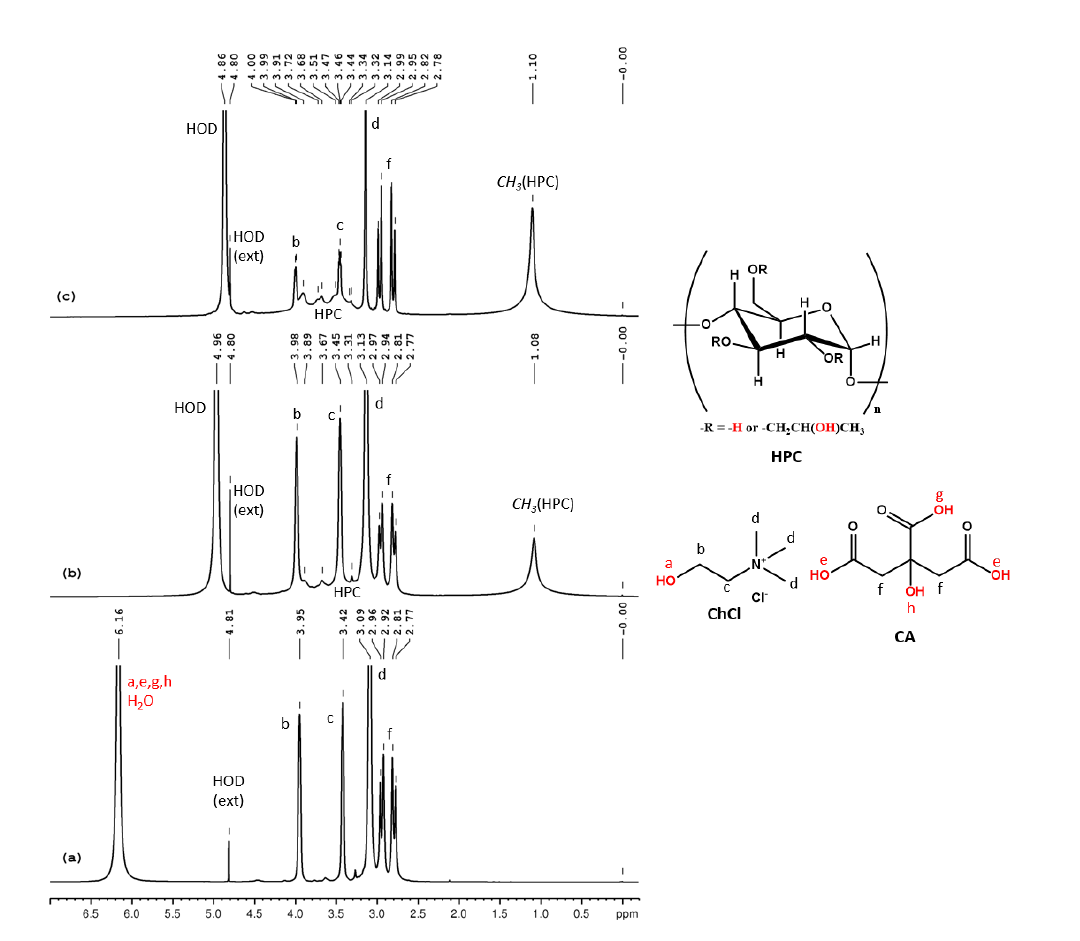
Figure 6. 1 H NMR spectra of ChCl-CA ( a ), HPC-ChCl-CA 29% ( b ) and HPC- ChCl-CA 17% ( c ). In red color are marked the exchangeable protons.